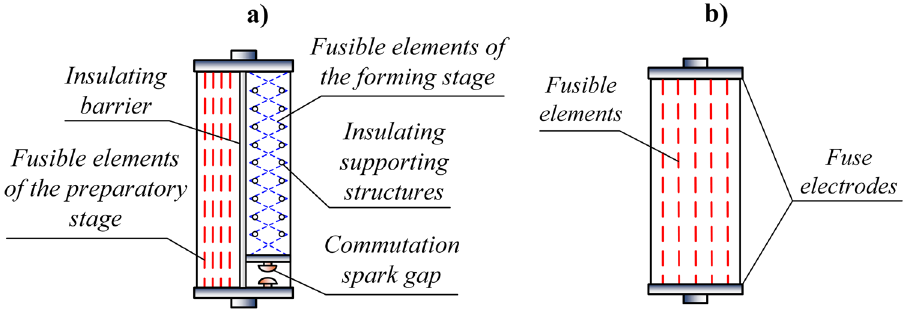
Figure 3. Comparison of the TSFF ( a ) and the single-stage FF ( b )